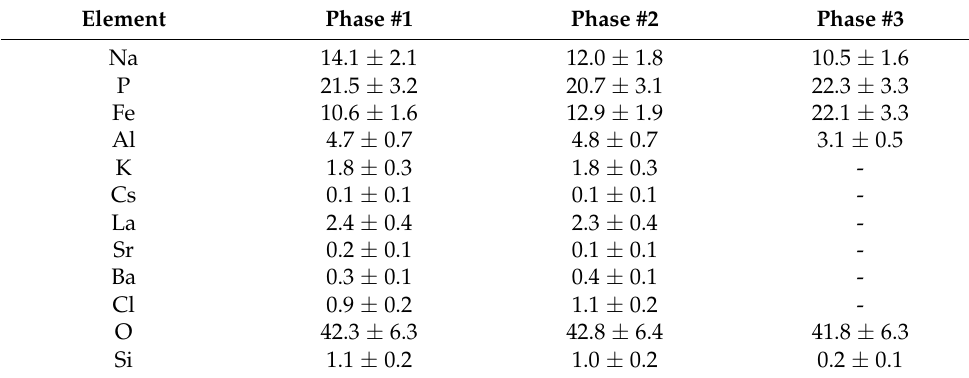
Table 2. The semiquantitative elemental composition (wt.%) of samples of NAFP glass after contact with a 0.7 wt.% H 2 O 2